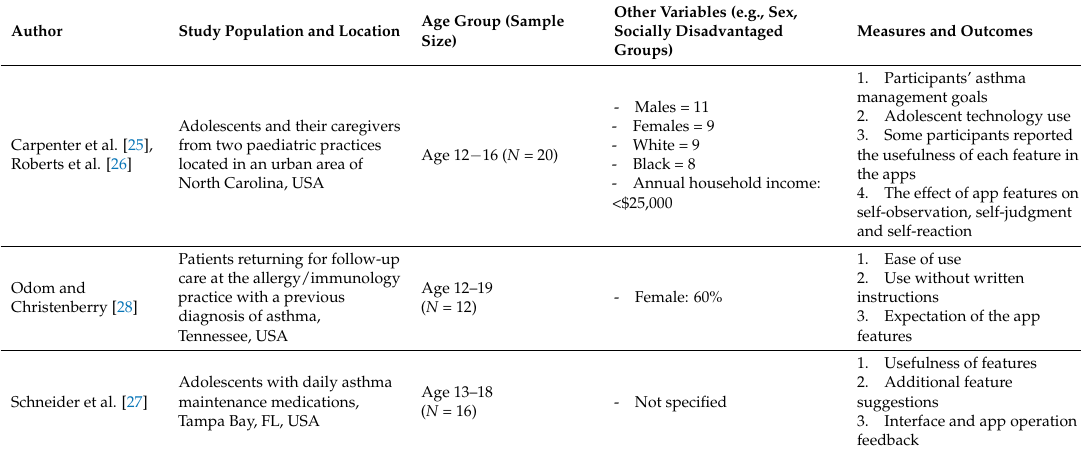
Table 4. Characteristics of the observational studies.